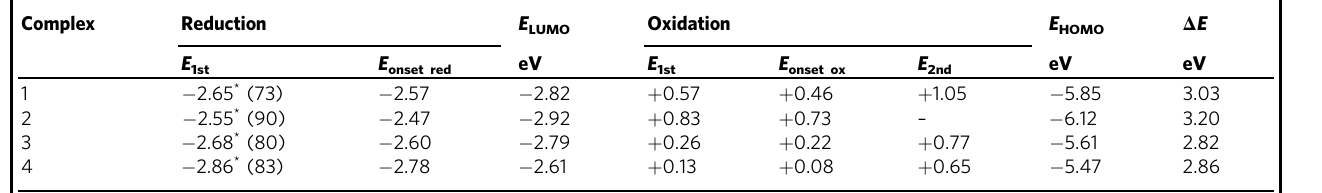
Table 2 Cyclic voltammetry of gold CMA complexes.